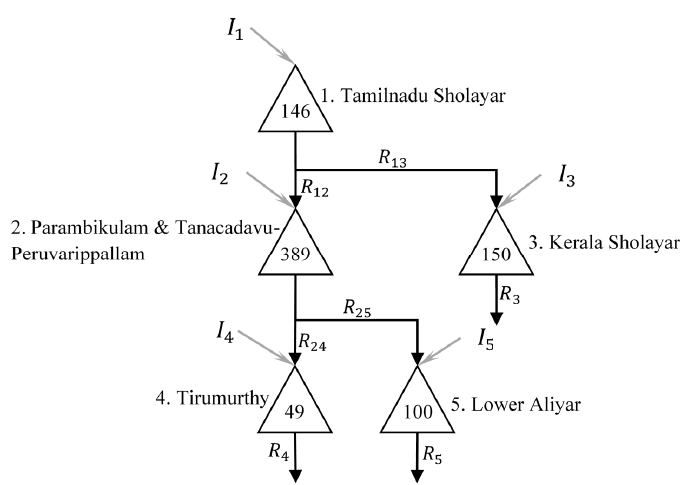
Figure 3. Parambikulam–Aliyar Project (PAP) system as studied.